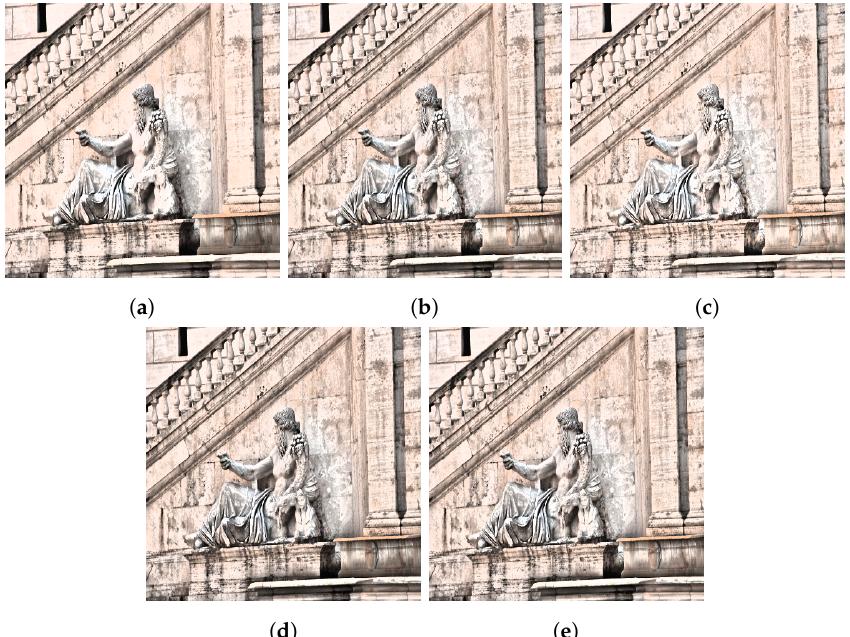
Figure 5. Comparison of single image dictionary and large datasets general dictionary in enhancement image: ( a ) Image enhancement using SCR same as Figure 2c; ( b ) Image enhancement using CSC Retinex, same as Figure 2f; ( c ) Image enhancement using CSC general dictionary; ( d ) Image enhancement using SVD-CSC single dictionary; ( e ) Image enhancement using SVD-CSC general